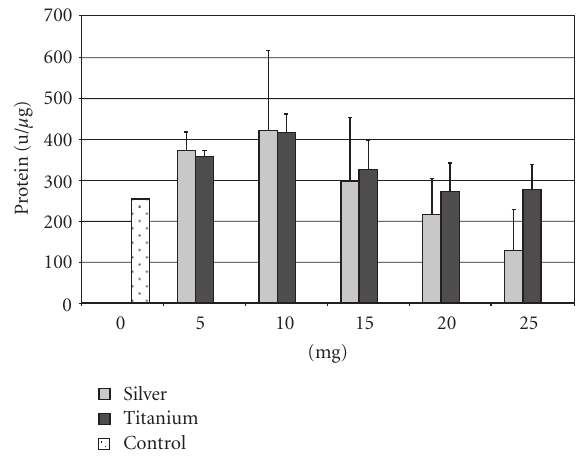
Figure 1: Alkaline phosphatase activity of the SAOS cell line after supplementation of 5–25 mg silver or